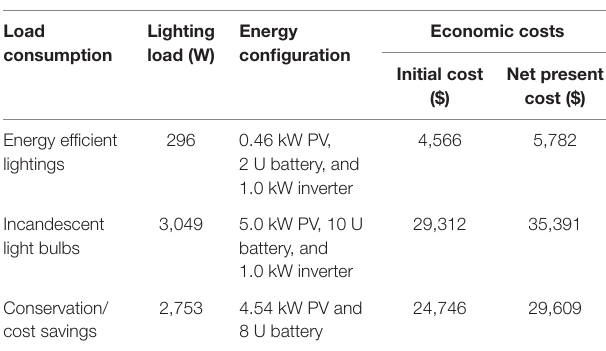
TaBle 6 | comparison of energy efficient lightings (excess option) with incandescent light bulbs for PV + surrette 6cs25P battery + inverter configuration.